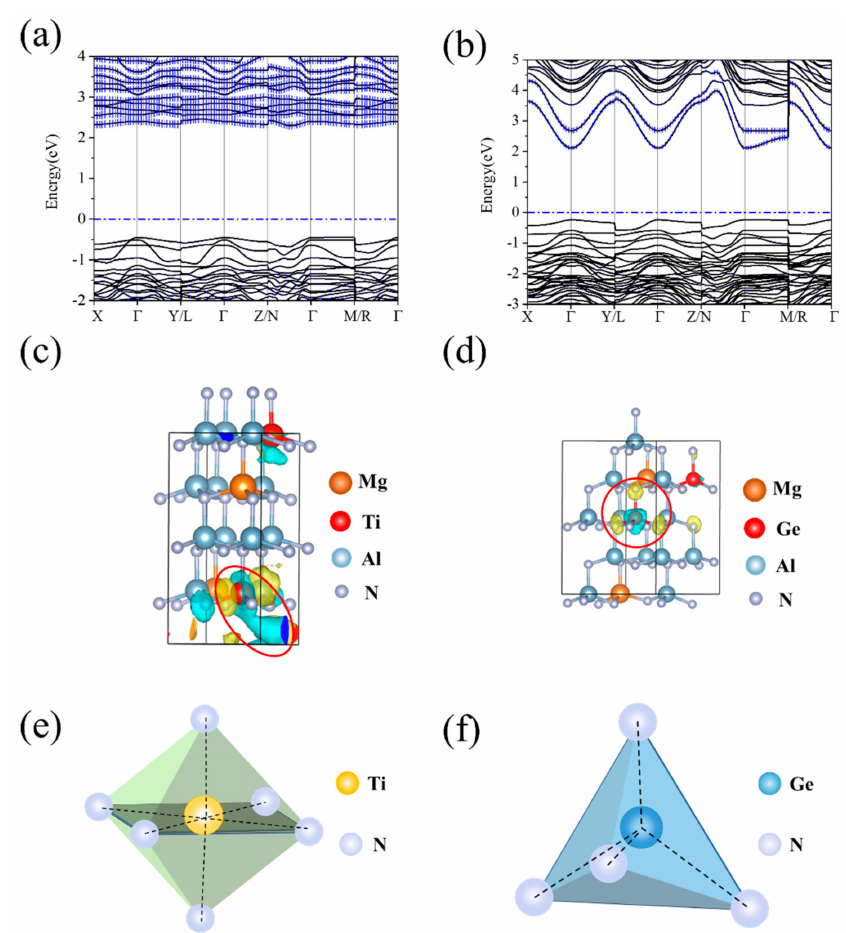
Figure 4. ( a , b ) Band structures of Mg 0.125 Ti 0.125 Al 0.75 N and Mg 0.125 Ge 0.125 Al 0.75 N. The blue error bar respectively represents the contribution of the d-electrons of Ti and s-electrons of Ge. ( c , d ) Wave function analyses of Mg 0.125 Ti 0.125 Al 0.75 N and Mg 0.125 Ge 0.125 Al 0.75 N are shown in red circles. Blue represents bonding orbitals, and yellow represents anti-bonding orbitals. ( e , f ) The structure of Ti 3 N 4 (Octahedral coordinates) and Ge 3 N 4 (Tetrahedral coordinates).